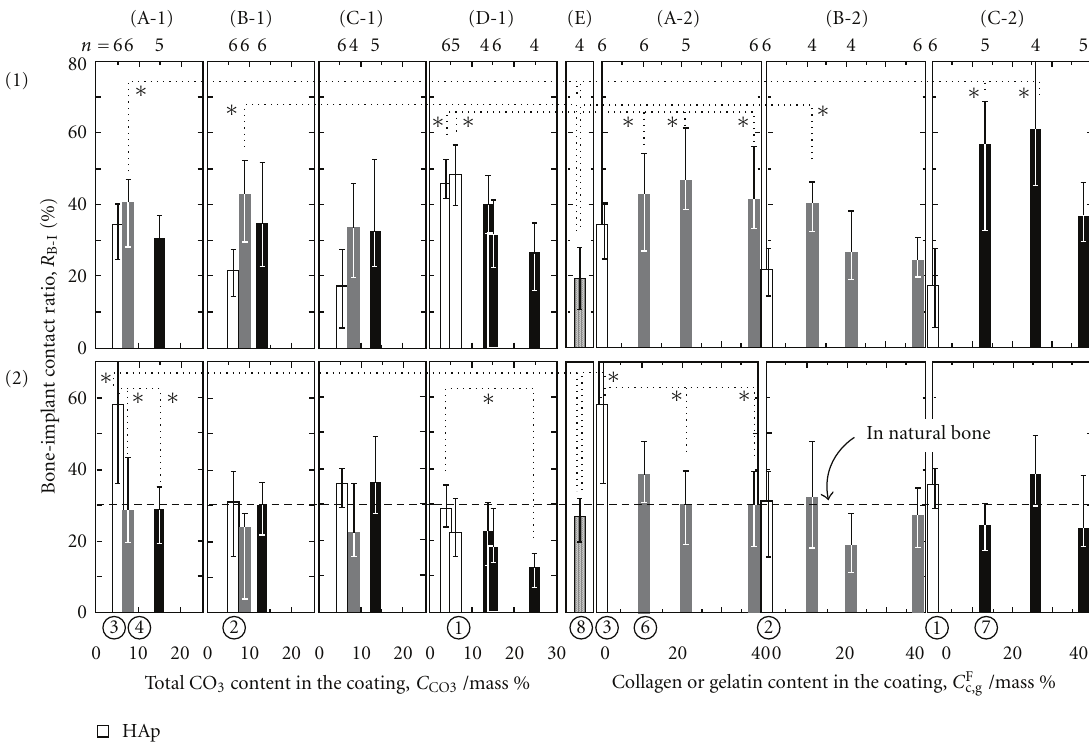
Figure 6: Bone-implant contact ratio, R B-I , for the various surface-coated samples (rats’ tibia, 14 days). ∗ P < 0 . 05 (1) cortical bone part, (2) cancellous bone part. (A) needle-like, (B) plate-like, (C) net-like, (D) spherical-like, (E) as-polished Ti.